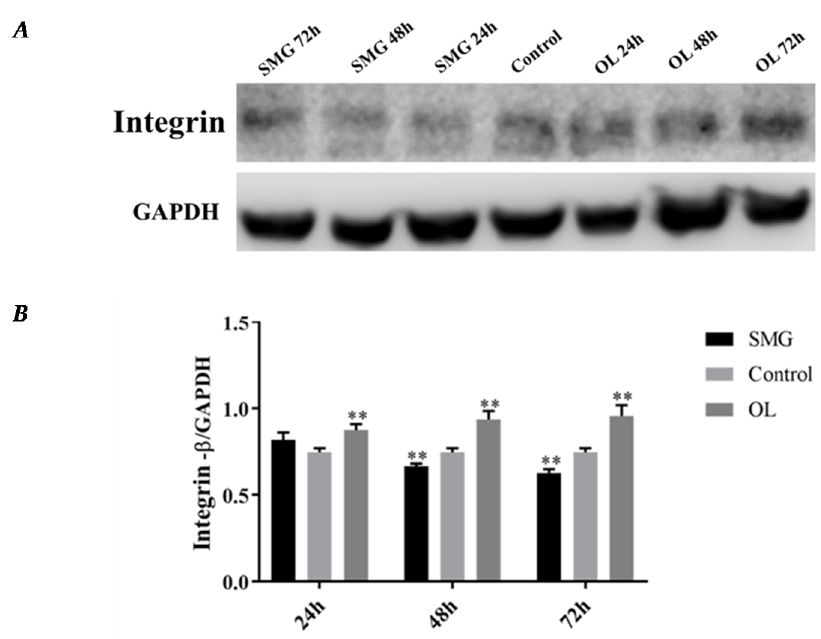
Figure 8. Western Blot analysis of integrin β1 in HUVEC cells after mechanical loading. A . Results for Western blots. B . Reflective densitometry of Western blots . Significant difference; ** p < 0.01, extremely significant.